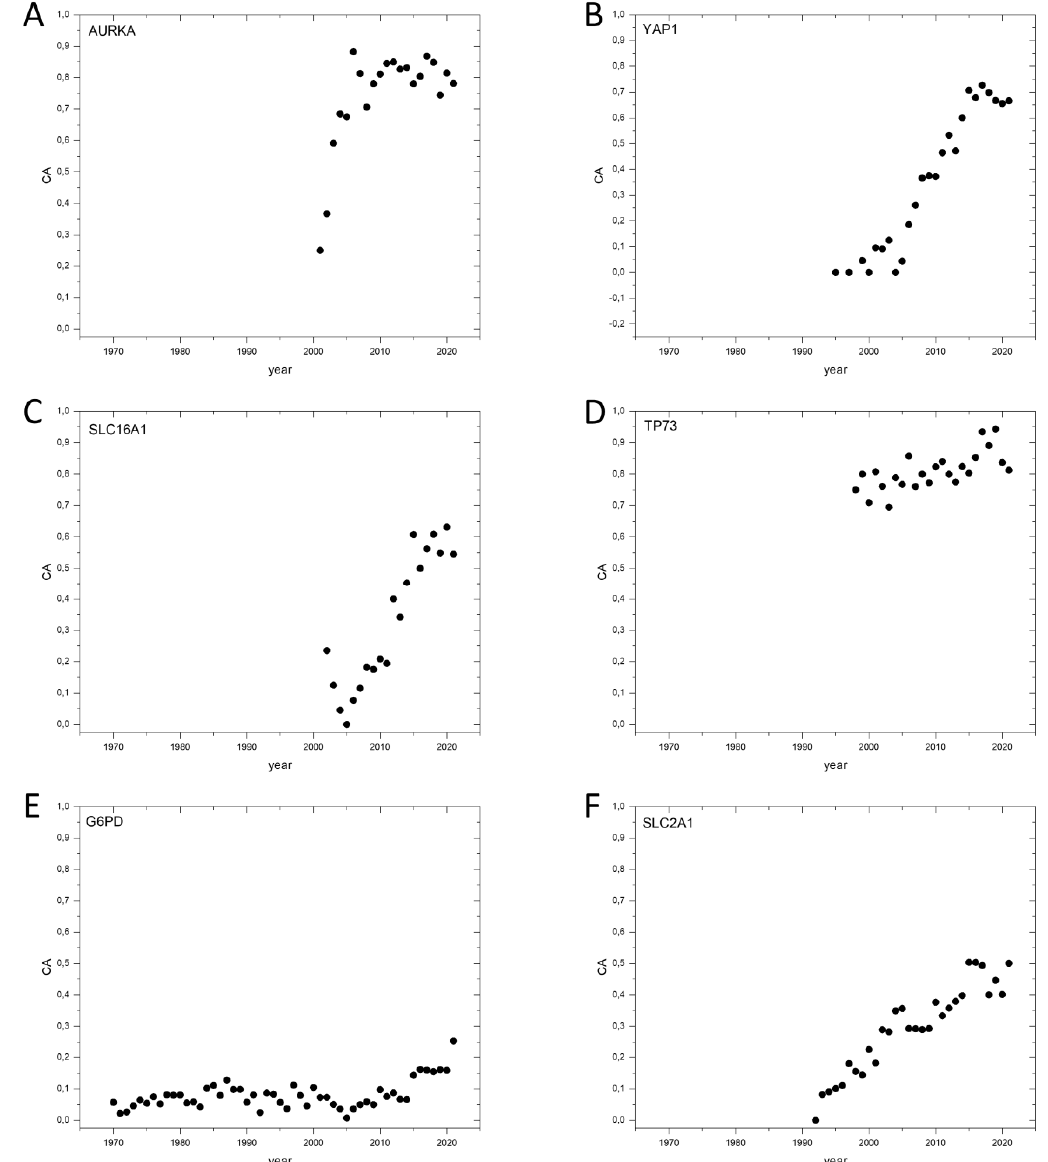
Figure 3. Dynamics of CA (Cancer_Pubs/All_Pubs) parameters of selected novel human cancer genes identified by Bányai et al., 2021 [3]. ( A ): AURKA , Aurora kinase A. ( B ): YAP1 , Transcriptional coactivator YAP1. ( C ): SLC16A1 , Monocarboxylate transporter 1. ( D ): TP73 , Tumor protein p73. ( E ): G6PD , Glucose-6-phosphate 1-dehydrogenase. ( F ): SLC2A1 , Solute carrier family 2, facilitated glucose transporter member 1.